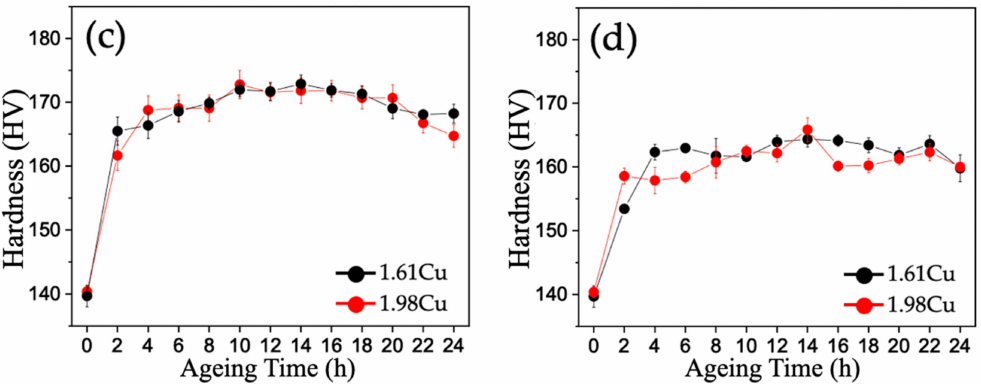
Figure 2. Hardness tests after artificial aging treatments at ( a ) 100 ◦ C, ( b ) 120 ◦ C, ( c ) 140 ◦ C, and ( d ) 160 ◦ C.